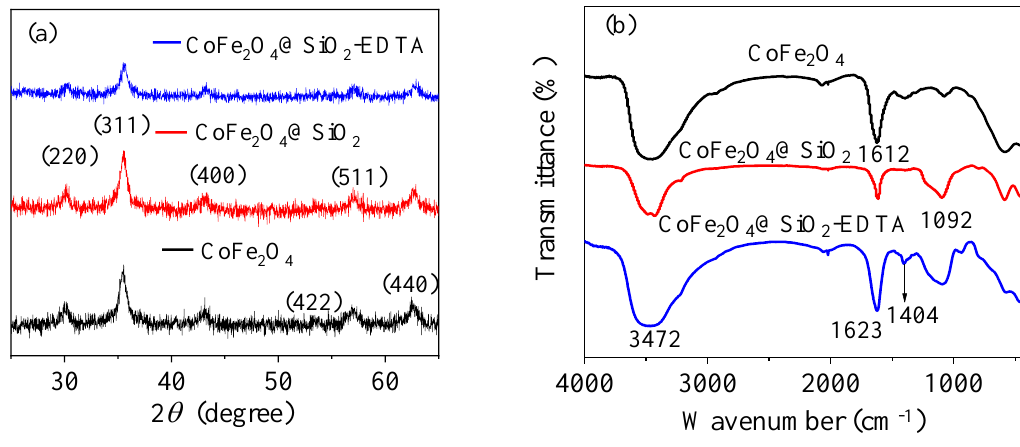
Figure 3. SEM image of CoFe 2 O 4 @SiO 2 -EDTA ( a ); EDS mappings of C ( b ), N ( c ), O( d ), Co ( e ), Si ( f ) and Fe ( g ) of CoFe 2 O 4 @SiO 2 -EDTA.